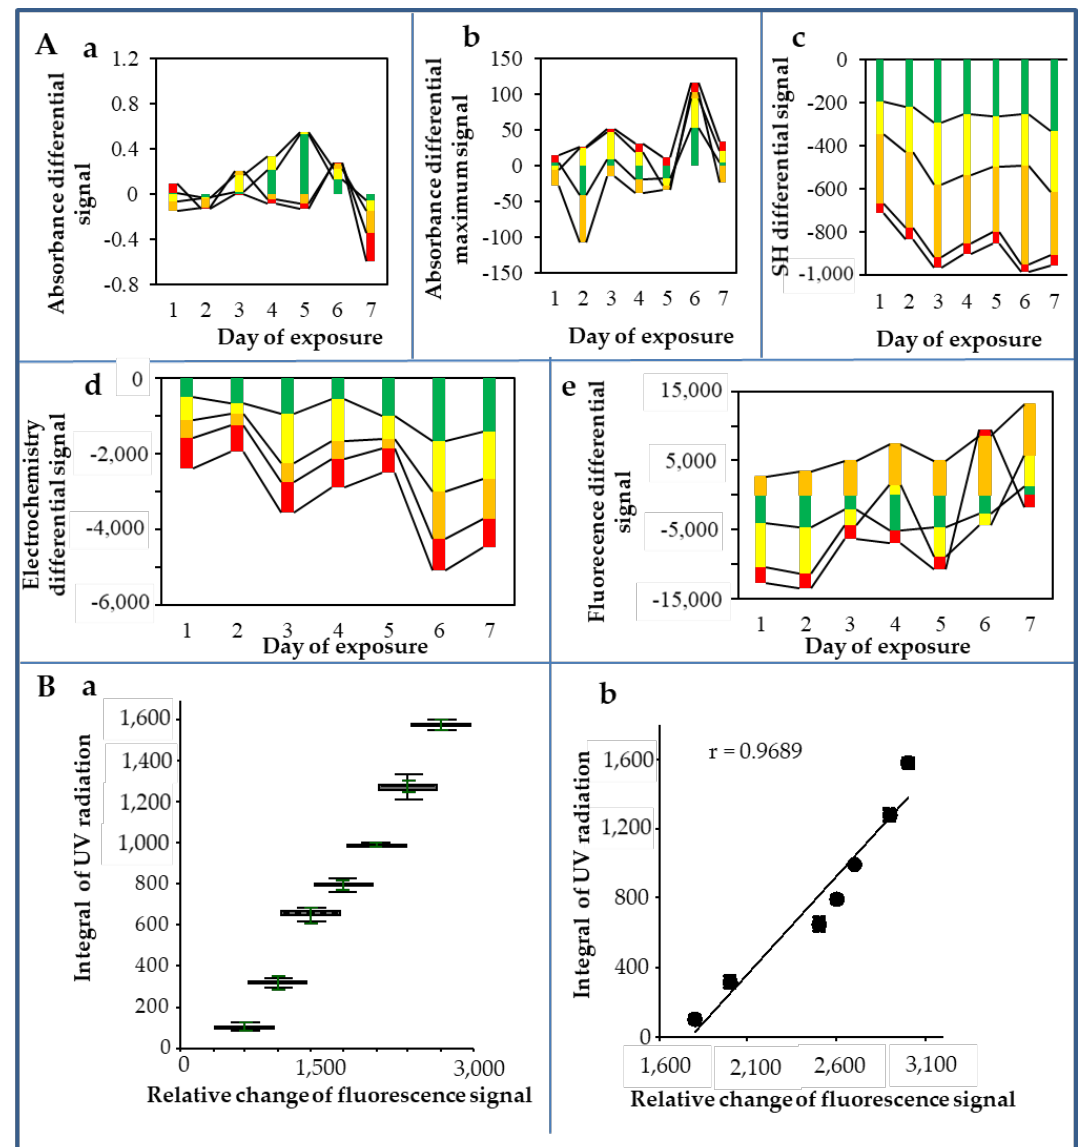
Figure 3. Changes in the observed biophysical parameters of CdTe QDs after exposure to the environment. ( A ) The average differential changes of CdTe QDs signals (subtracted from individual QDs without the impact of environmental exposure, i.e., controls) were: maximum absorption ( a ), peak absorption ( b ), sulfhydryl group signal ( c ), cadmium redox signal ( d ), and fluorescence signal ( e ). The individual tested color QDs are marked in the graphs with the appropriate colors. ( B ) The dependence of UV irradiance on QDs response expressed as a fluorescence signal ( a ) robust box analysis; ( b ) correlation. The results were evaluated as averages of five replicates. Further experimental details are described in the Materials and Methods section.